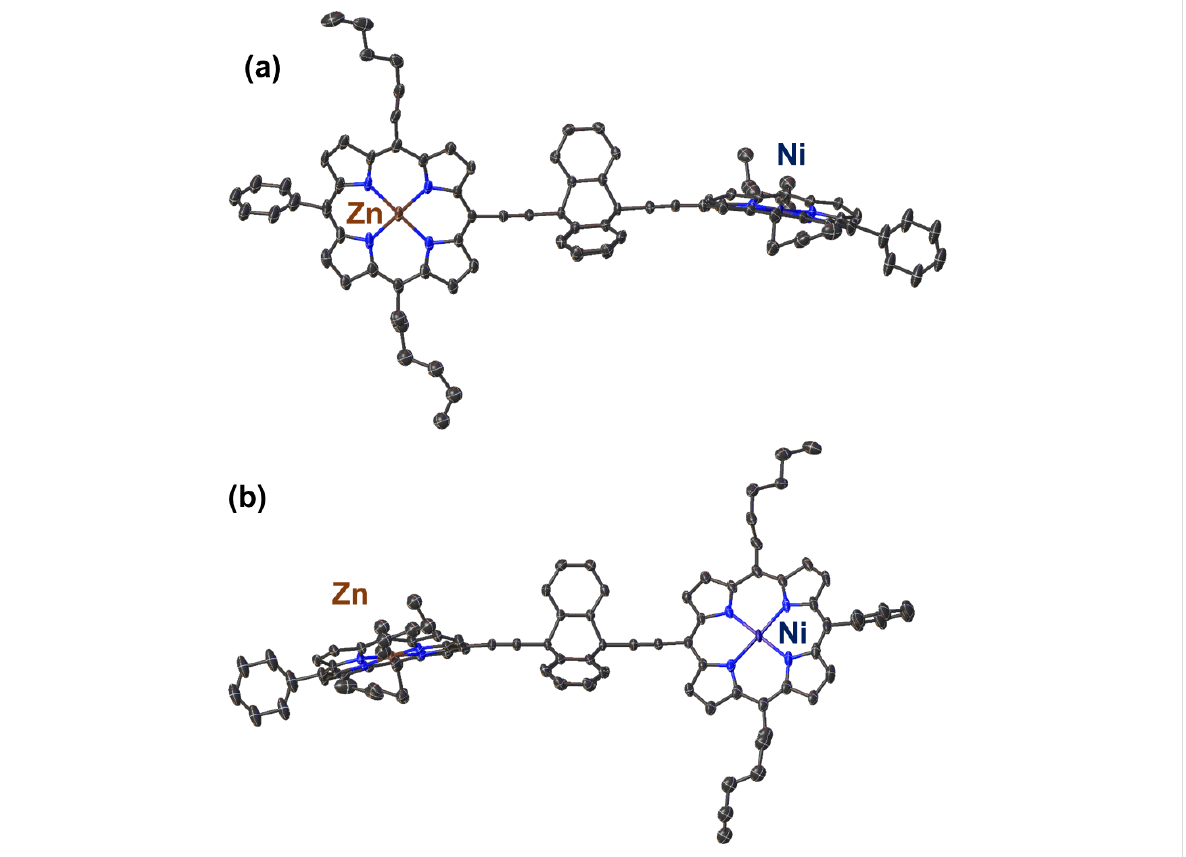
Figure 3: Single crystal X-ray structure of triptycene-linked zinc-nickel porphyrin dimer 16 showing the conformation within the crystal structure; (a) top-view of zinc porphyrin; (b) top-view of nickel porphyrin. Hydrogen atoms and minor disorder are omitted for clarity (thermal displacement